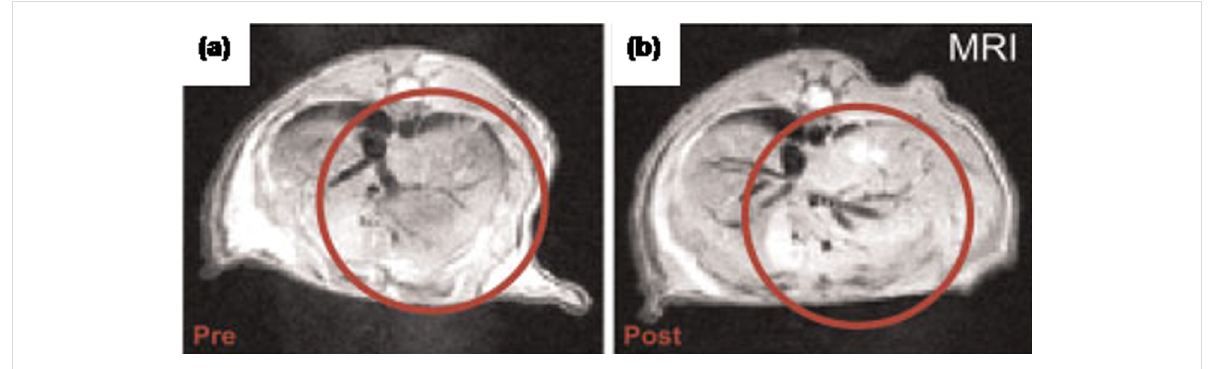
Figure 2: MR image of mice liver (a) prior to and (b) 24 h after injection of the trimodal NPs. Reproduced with permission from [18]. Copyright 2010